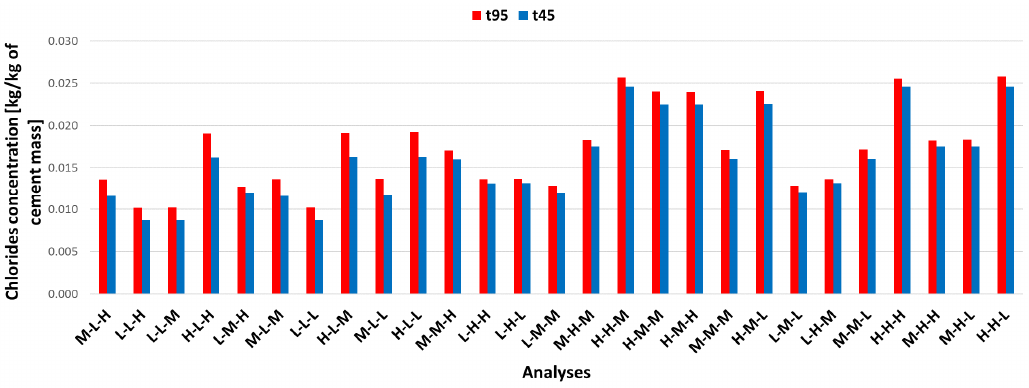
Figure 15. Chloride concentration at reinforcement depth as a function of chloride parameter combination and corrosion period (t45 = 45 years, t95 = 95 years).